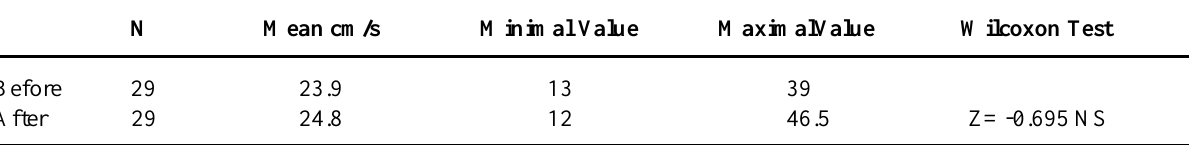
Table 1 – Statistical analysis of differences between the mean peak systolic velocity of cavernous arteries before and after use of sildenafil citrate.